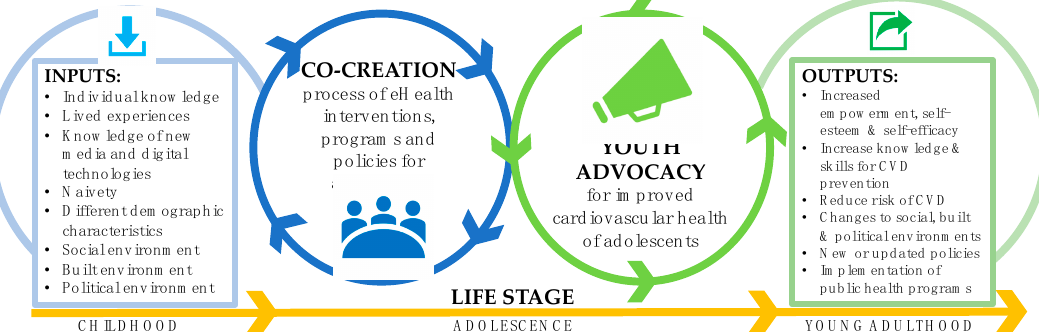
Figure 1. A conceptual model of the inputs and outputs of the co-creation and youth advocacy processes for cardiovascular prevention during adolescence.